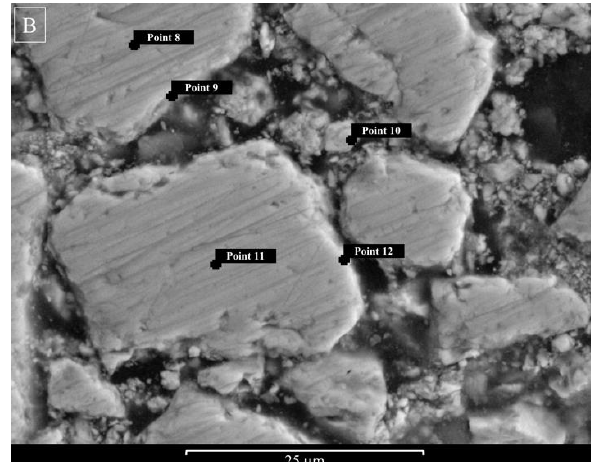
Figure 10. SEM images of the initial FeAsS particles ( A ) and particles after hydrothermal treatment ( B ) in cross-sectional view; bulk particles ( C ) after hydrothermal treatment. Table 3 shows the chemical composition of the particles at the points indicated in Figure 10. SEM scanning in the BSE/SE regime cannot visually determine a clear boundary between the surface film and the unreacted core, although the results of chemical analysis at Points 9, 10 and 12 (Table 3, Figure 10B) distinctly indicate the presence of copper and an increase in sulfur content. The EDS analysis of the bulk particles after hydrothermal treatment (Table 3, Figure 10C) also indicates that the surface of the particles becomes enriched with sulfur and contains copper.